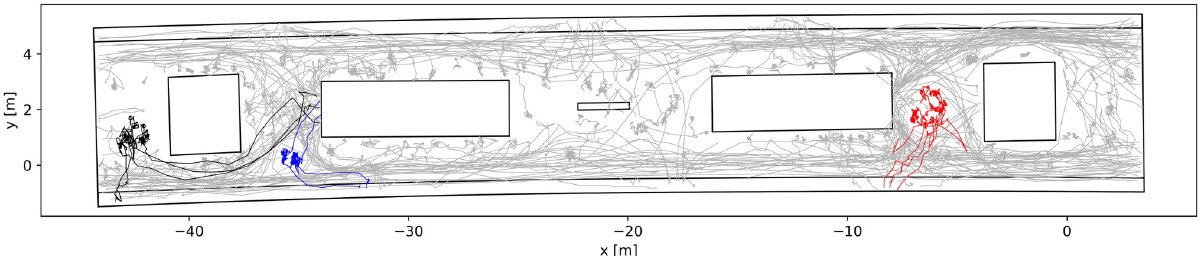
Fig 6. Trajectories of pedestrians at the platform in an exemplary six-minute interval. Trajectories of groups are indicated in colour. Group of two in blue, group of three in black and group of five in red.